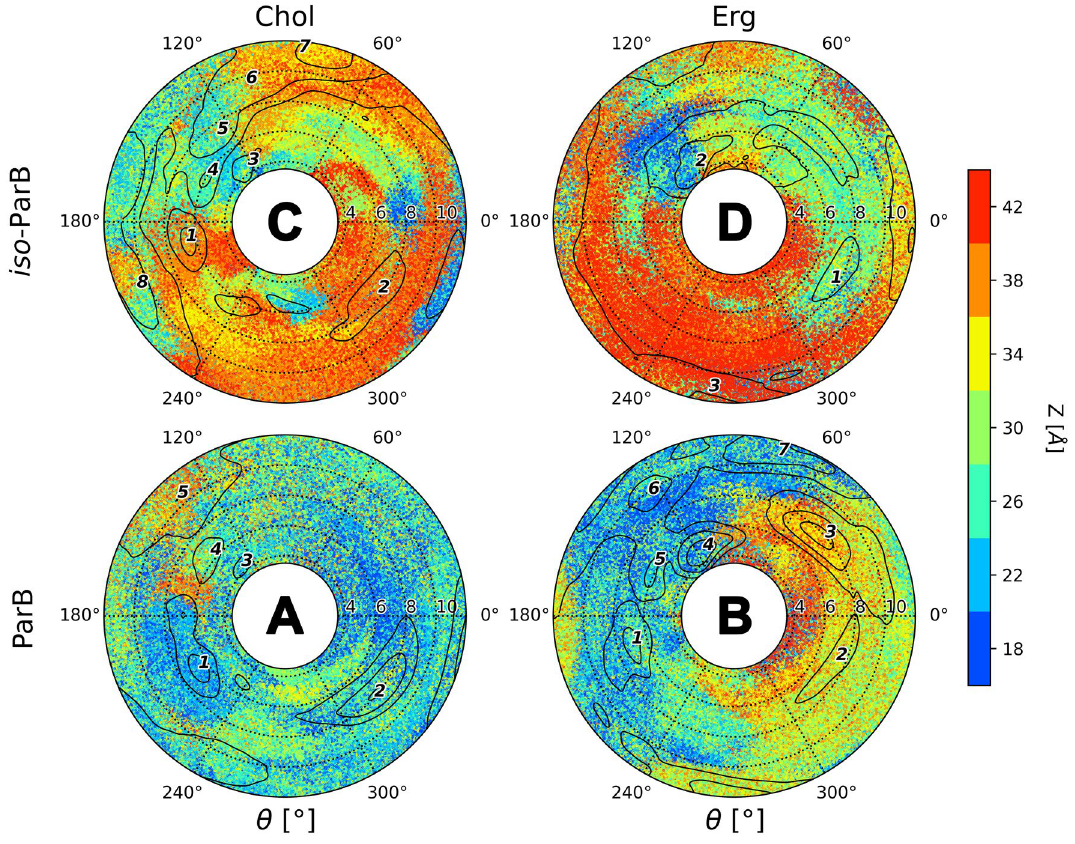
Figure 9. Interactions of partricin’s B ( A & B ) and iso-partricin’s B ( C & D ) side chain with an opposite leaflet of a lipid bilayer.